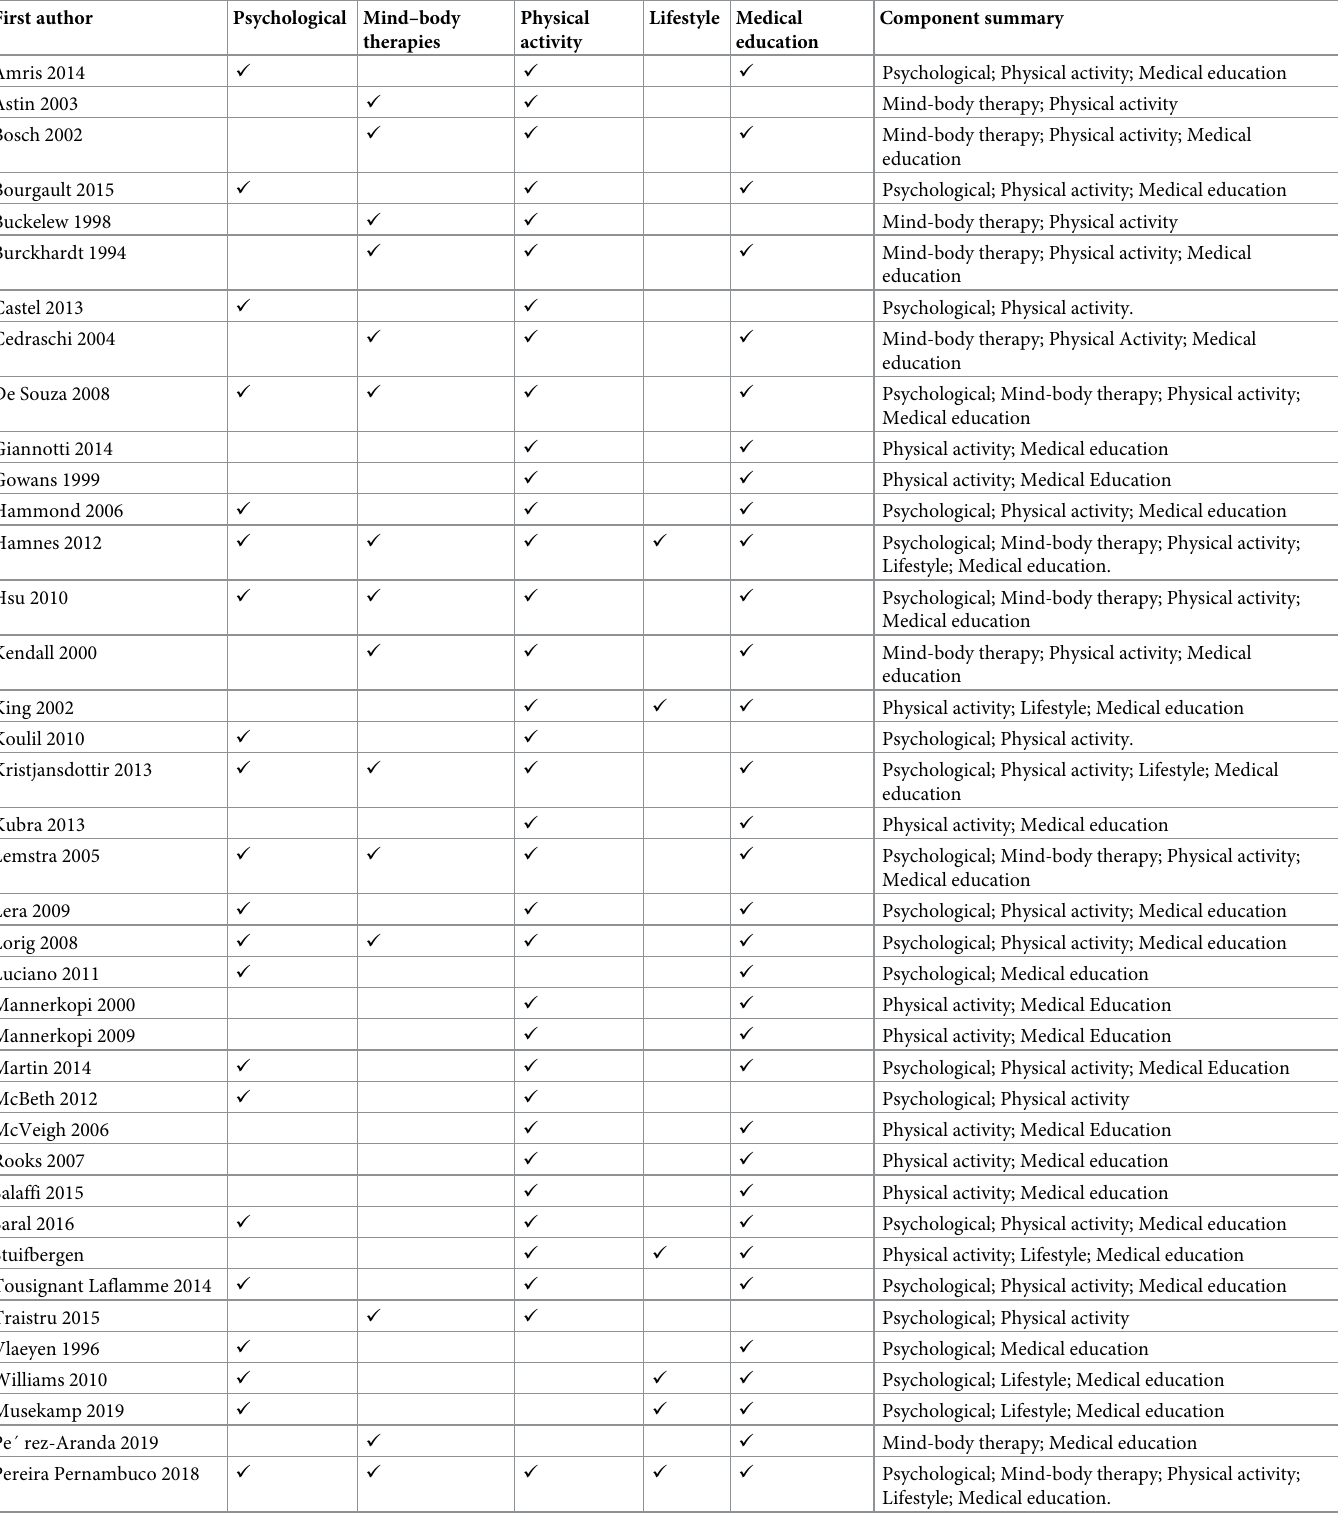
Table 1. Components of